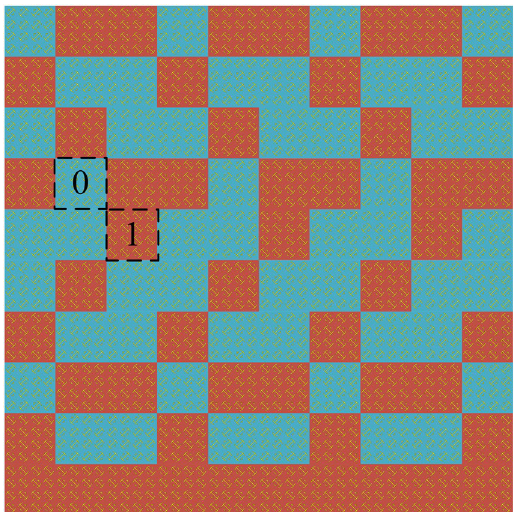
Figure 3. The 1-bit random coding diffusion metasurface distributions on a large area (2.4 × 2.4 m 2 ) containing 100 lattices. The “0” and “1” lattices comprise 4 × 4 equivalent elements and are distinguished by blue and red colours, respectively.